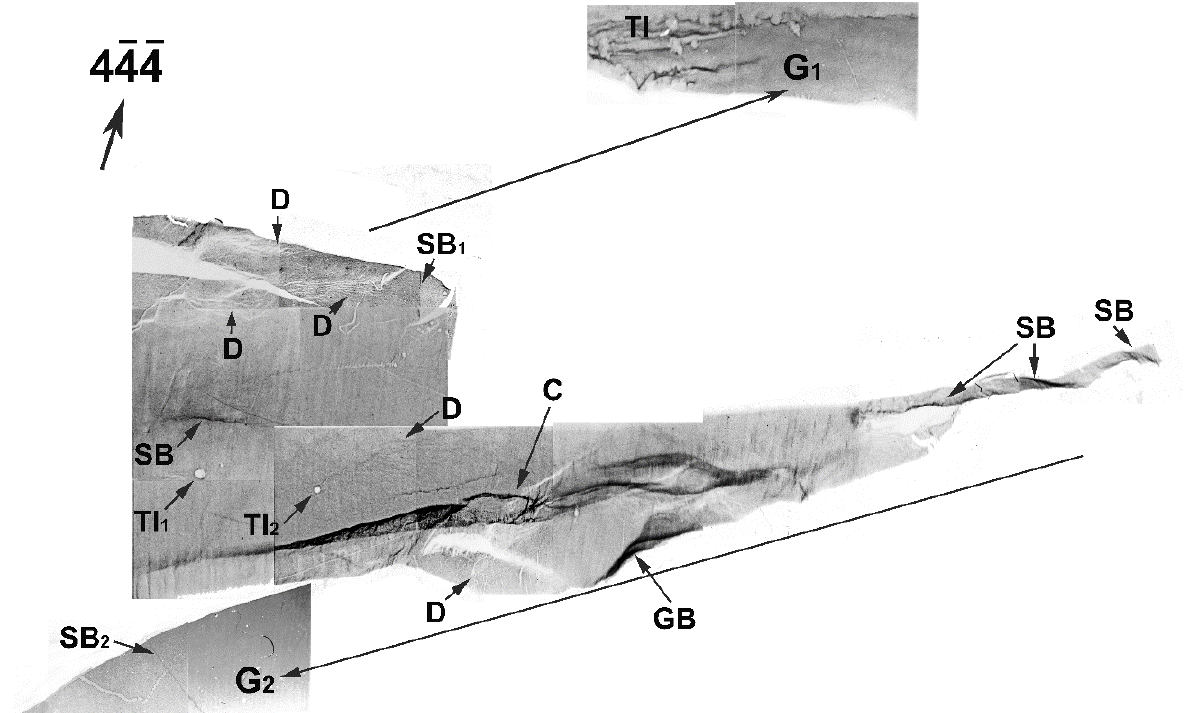
Figure 7. Back reflection topographs recorded from the grown crystal region of F1-02 showing extensive defect structures. Two individual grains (G 1 and G 2 ) are observed. High density of dislocation network (D) and subgrain boundaries (SB) are generated near the periphery and around the crack (C).